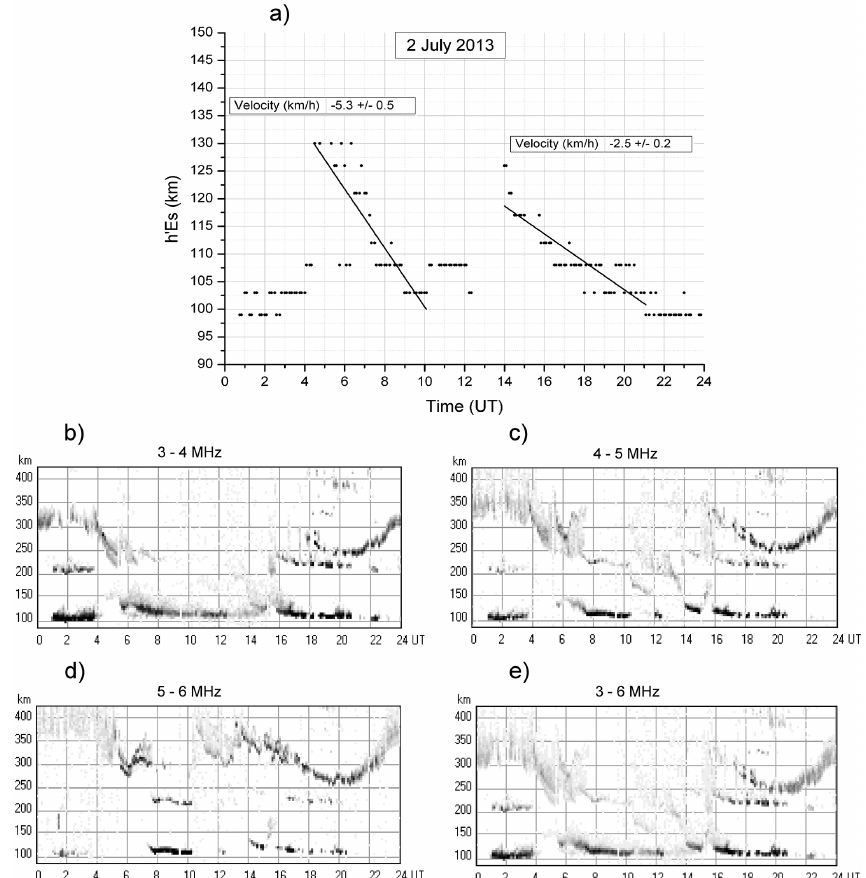
Figure 7. (a) h’Es values manually validated for the 2 July 2013, with the corresponding linear fits, and the HTI plots generated for the same day for different frequency ranges: (b) 3–4MHz, (c) 4–5MHz, (d) 5–6MHz, and (e)